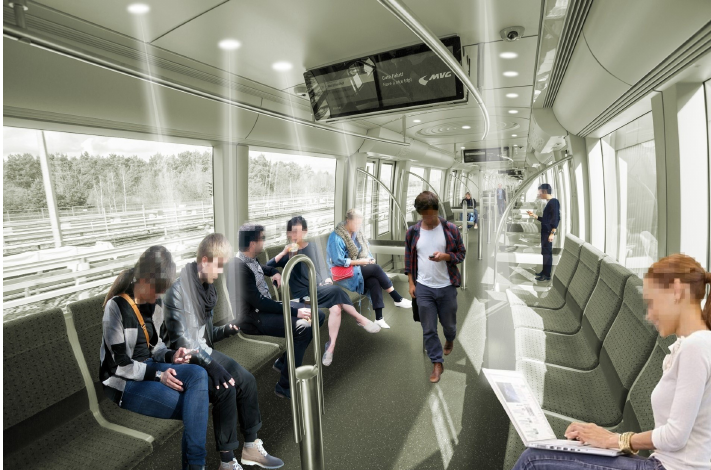
Figure 1. An illustrative scenario for a Visible Light Communications (VLC)-based multiuser downlink data transmission. Table 1. Differences between VLC and RF systems